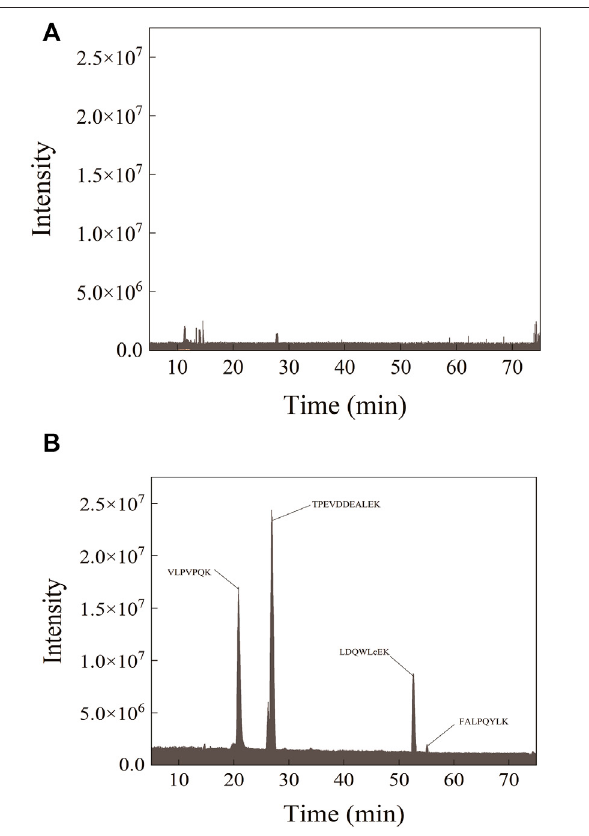
FIGURE3| Peptideiondiagrams ofmassspectrometry PRMbefore (A) and after (B) enzymatic digestion of the